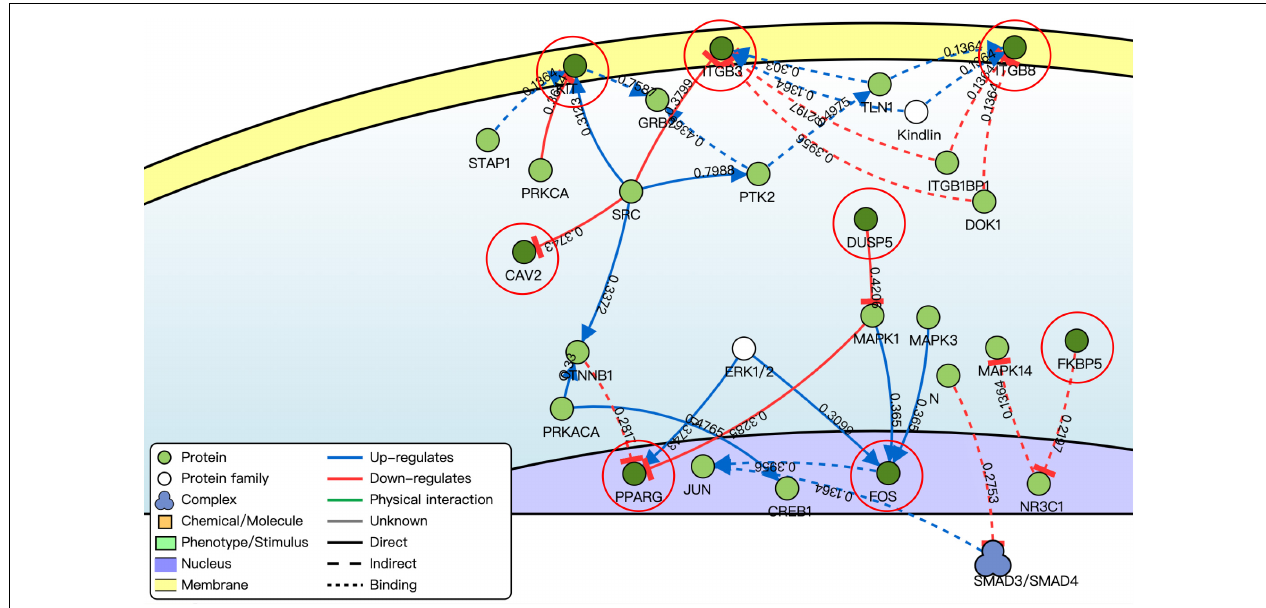
FIGURE 5 | Causal interaction analysis of targeted DE mRNAs of GSE71331/71332 (inside the red circle) and their first neighbor genes (outside the red circle) by using DisNor. The numbers on the line stand for correlation coefficient.